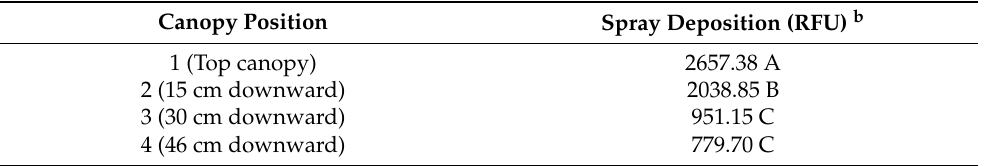
Table 8. Overall spray deposition a for different soybean canopy levels. Data were pooled over years. A Means within a column followed by the same letter are not significantly different ( α ≤ 0.10).